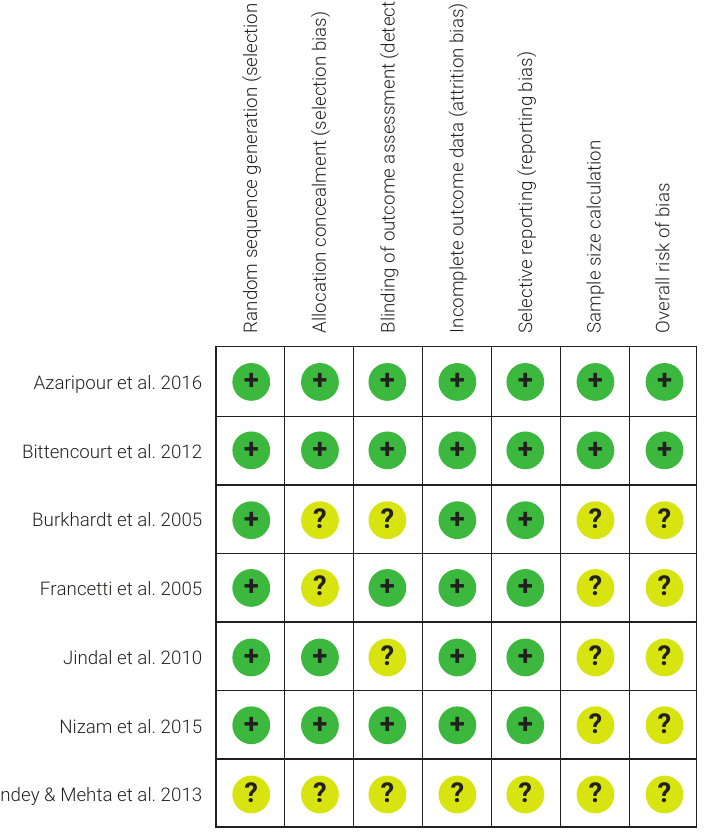
Figure 2. Risk of